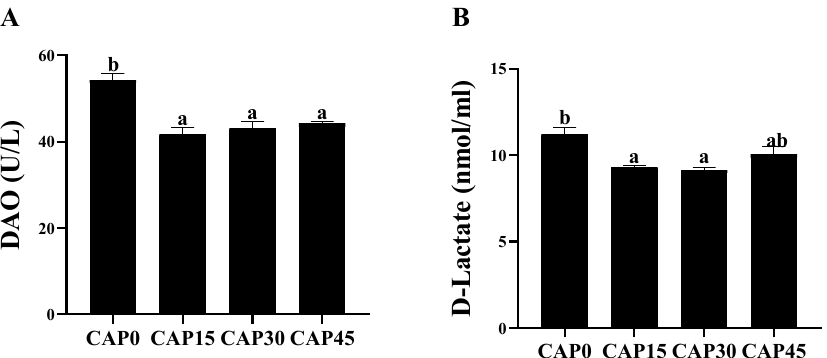
Figure 2. Gut epithelial permeability of large yellow croakers fed diets with different levels of CAP ( Clostridium autoethanogenum protein): ( A ) Diamine oxidase (DAO), and ( B ) D-lactate. Bars with different letters indicate significant difference ( p < 0.05).